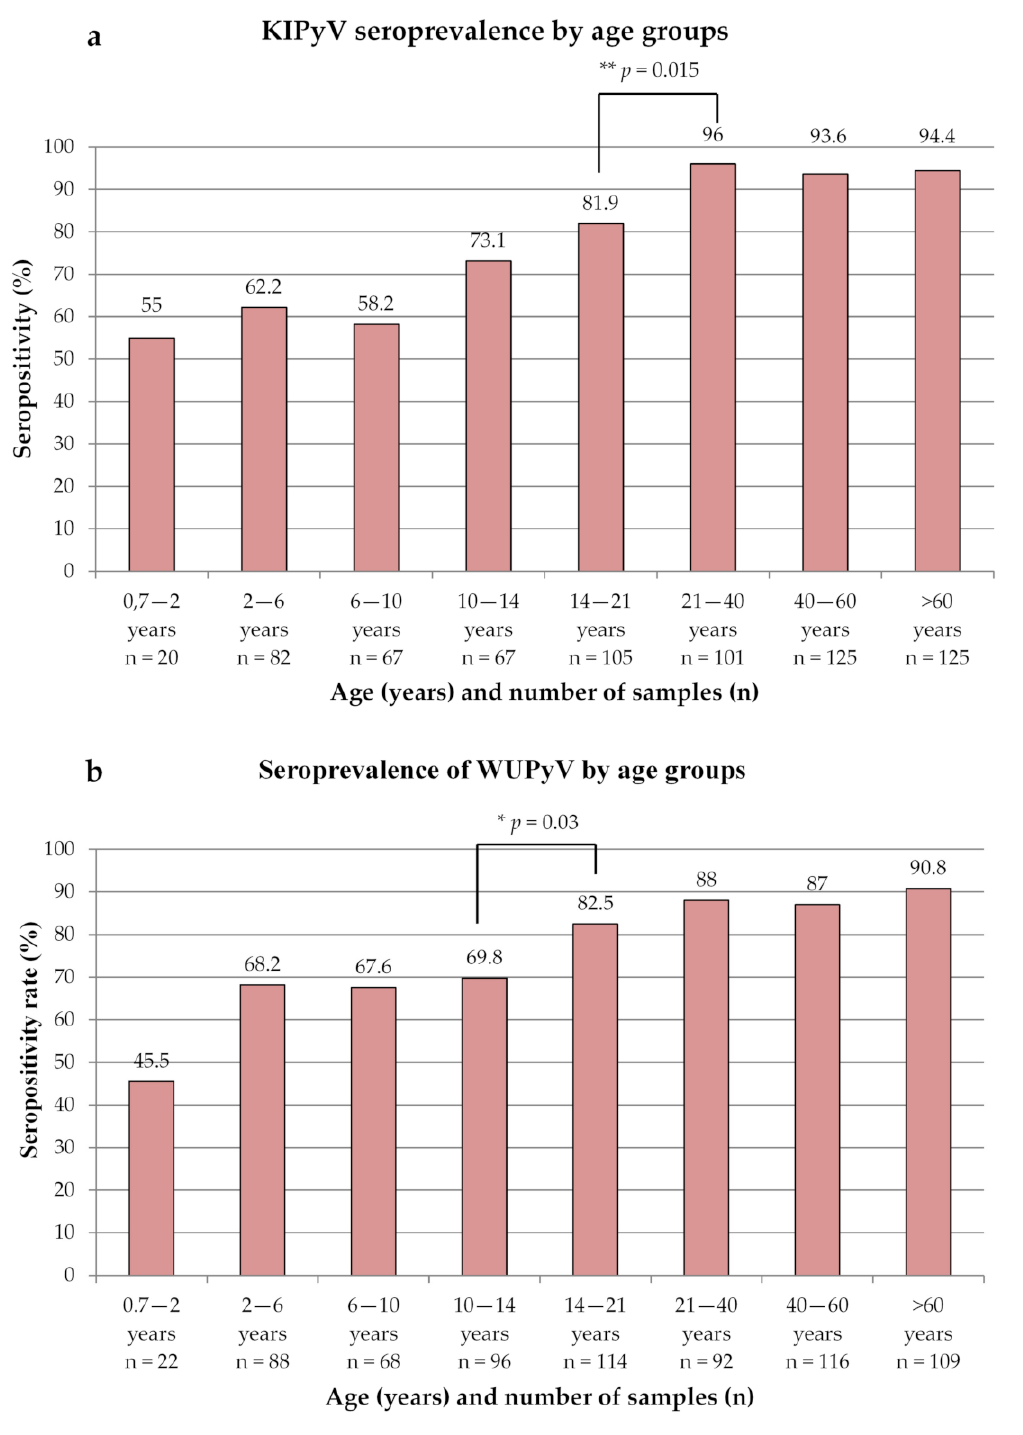
Figure 2. Age distribution of seropositivity for KI polyomavirus (KIPyV) ( a ) and WU polyomavirus (WUPyV) ( b ) seropositivity rates by age